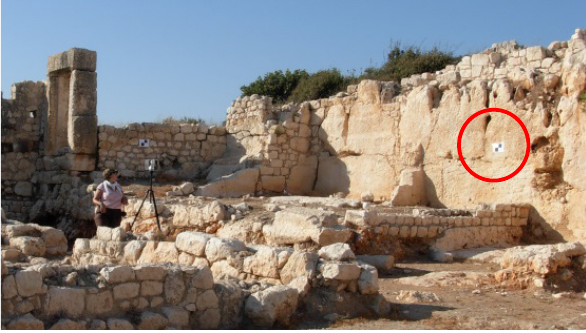
Figure 9. Planar target.